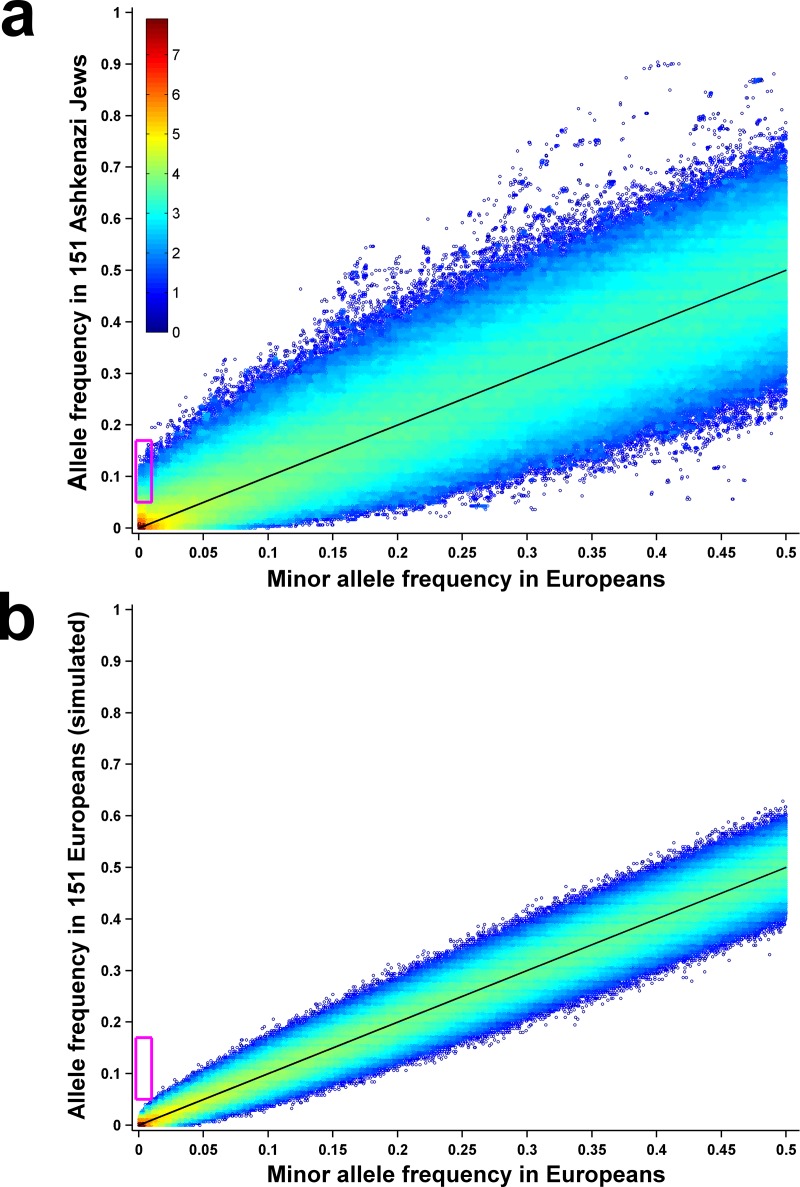
Founder effect in Ashkenazi Jews.(a) Minor allele frequency of variants in 7509 Europeans (X-axis) vs. their allele frequency in 151 Ashkenazi Jews (Y-axis). Each dot represents one of ~90.5 million genetic variants from the gnomAD database. Color displays density, i.e. the number of variants in that region of the plot, on a log10 scale. The magenta rectangle encloses all variants that are rare (MAF<1%) in Europeans but common (MAF≥5%) in Ashkenazi Jews. Black line shows y = x. (b) Same as in (a), but with allele frequency in a random sub-sample of 151 Europeans shown on the Y-axis.